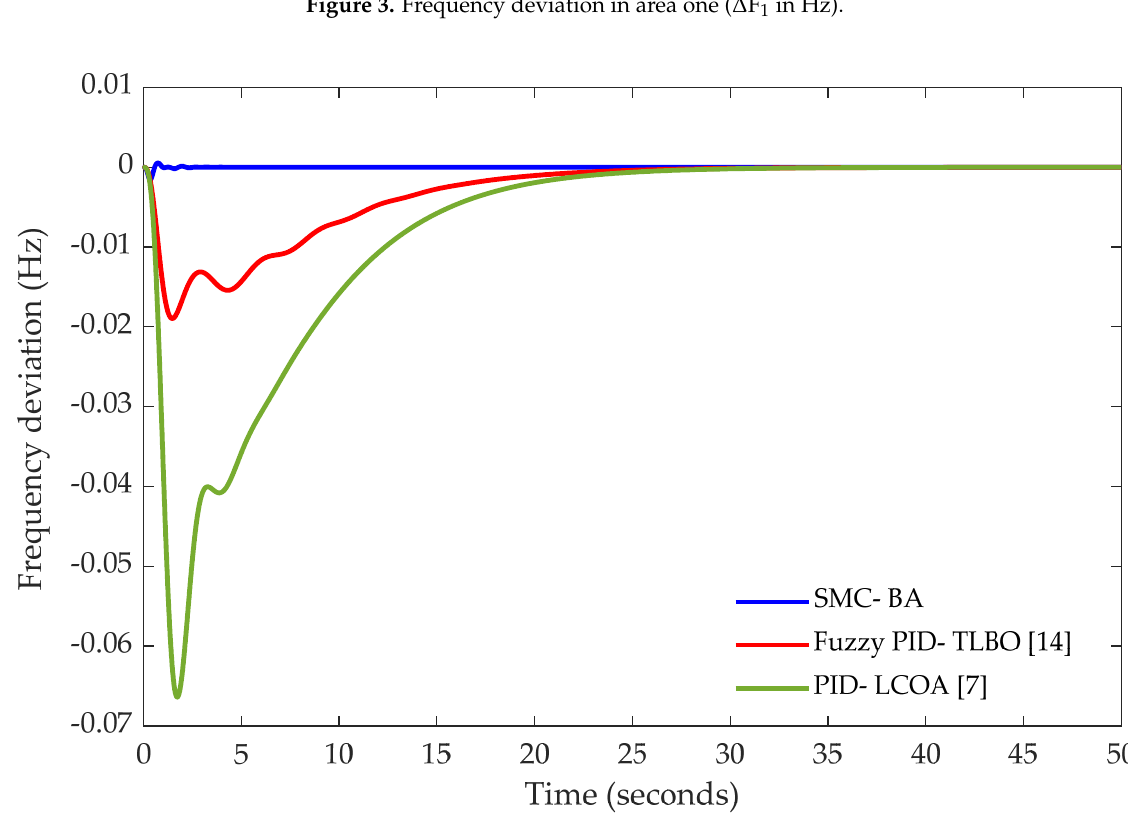
Figure 4. Frequency deviation in area two ( ∆ F 2 in Hz).